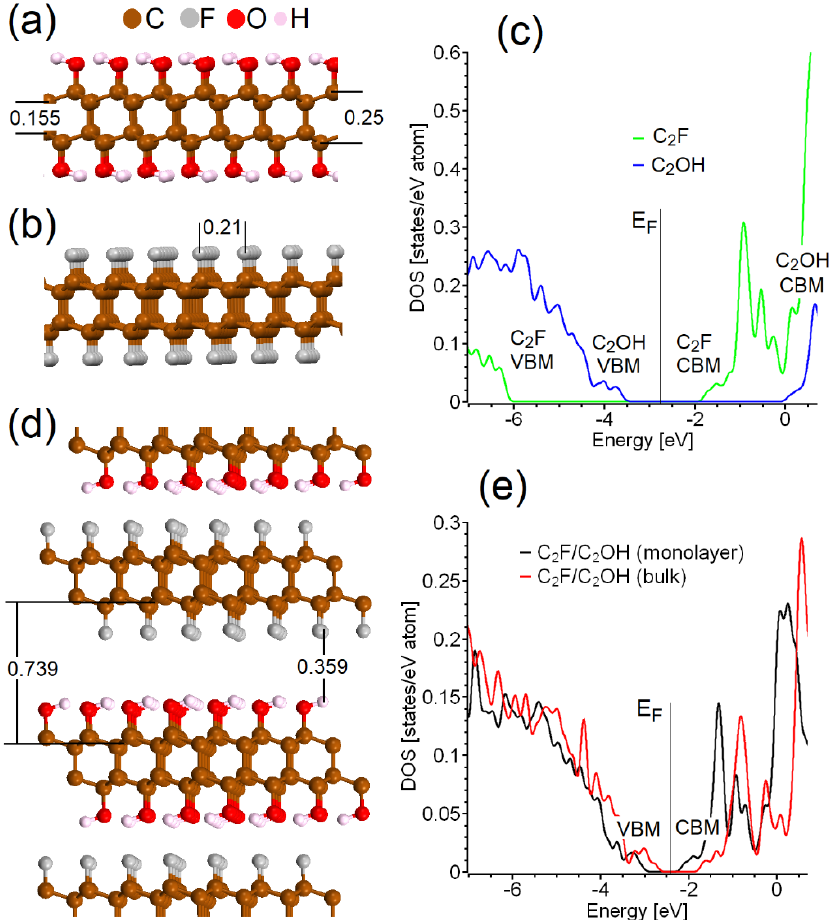
Figure 1. Side view of optimized atomic structure of diamenes C 2 OH ( a ), C 2 F ( b ), and part of bulk diamene with alternating C 2 F/C 2 OH structure ( d ). On the right are corresponding total densities of states of C 2 OH and C 2 F monolayers ( c ) and C 2 F/C 2 OH-structure in bulk ( e ) and single C 2 F/C 2 OH- layer form. All distances on panels ( a ), ( b ), and ( d ) are reported in nanometers. E F is a Fermi energy.